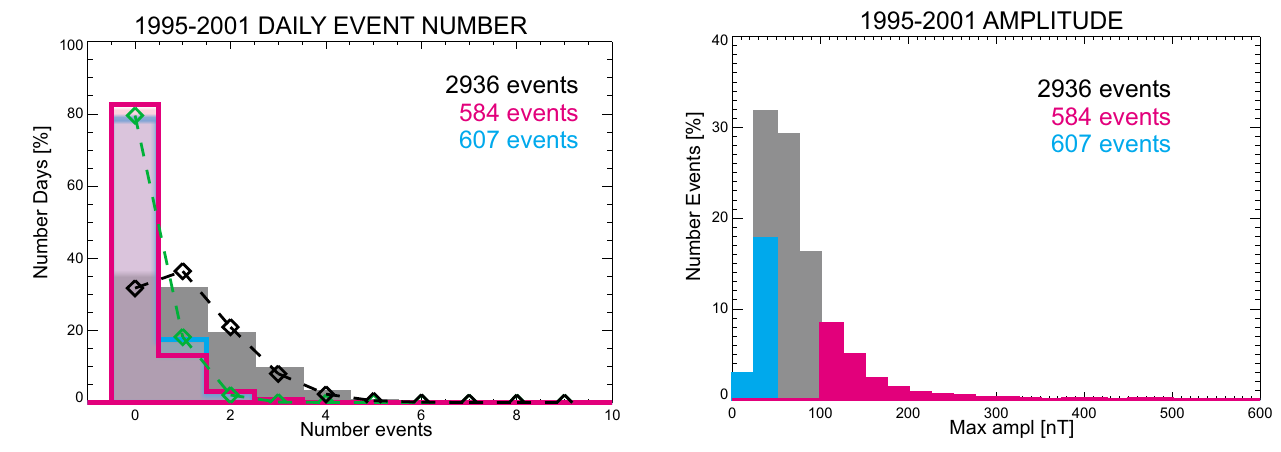
Fig. 10. The distribution of event amplitudes is displayed using bins of 25 nT. The large amplitude subgroup of events is marked in magenta and the small amplitude subgroup in